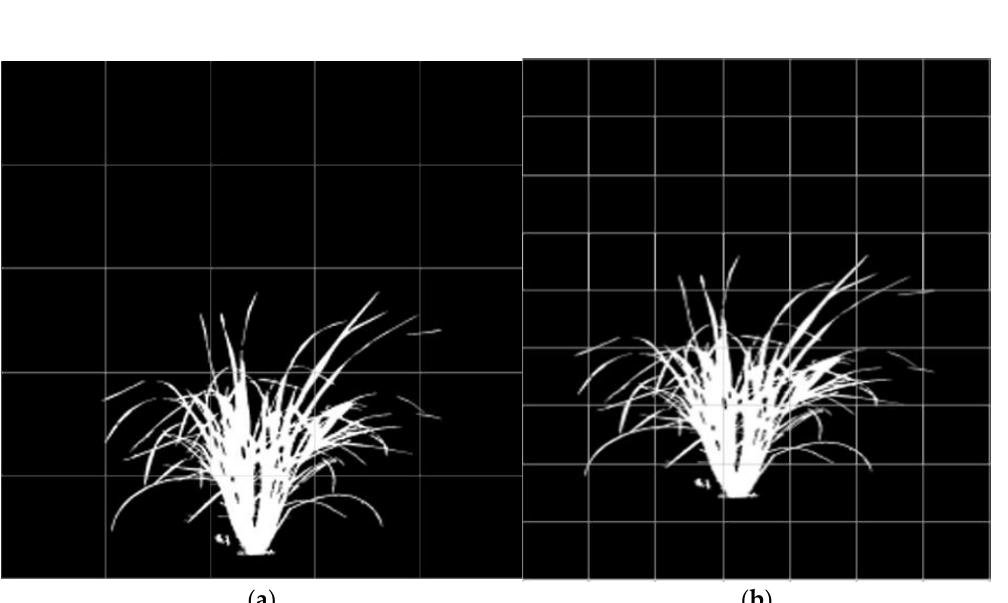
Figure 3. Box-counting method. ( a ) Cover the image with big boxes; ( b ) cover the image with small boxes.